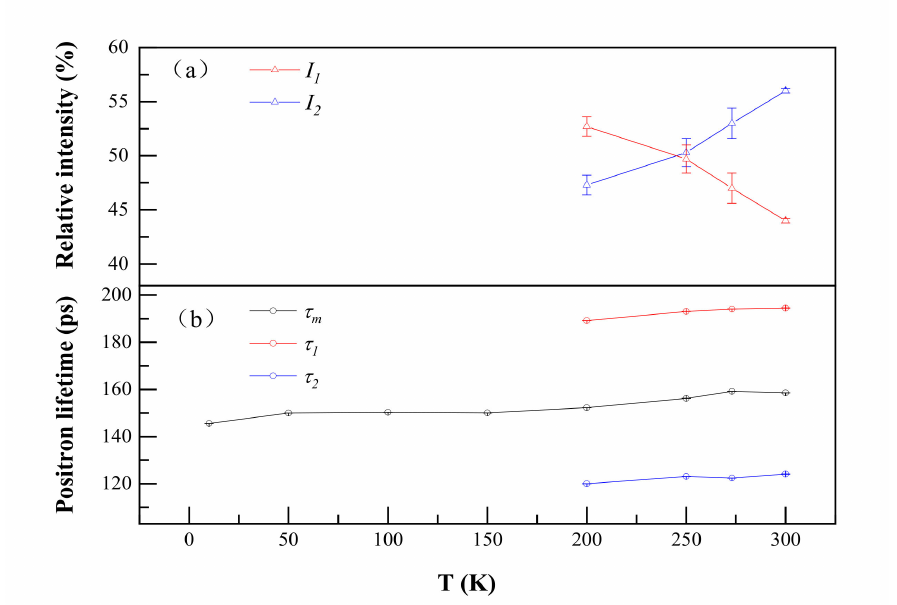
Figure 2. Positron annihilation lifetimes ( a ) and their relative intensities ( b ) of Al-0.2 wt.%Ag as a function of temperature. τ 1 , τ 2 and τ m represent a short lifetime, long lifetime and mean lifetime in the positron annihilation spectrum. I 1 and I 2 represent the relative intensity of the short lifetime and long lifetime.